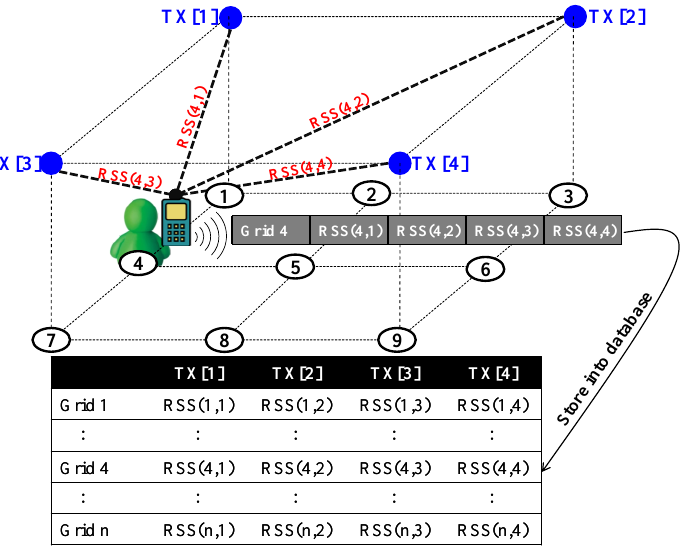
Figure 1. The calibration stage of the fingerprinting algorithm.